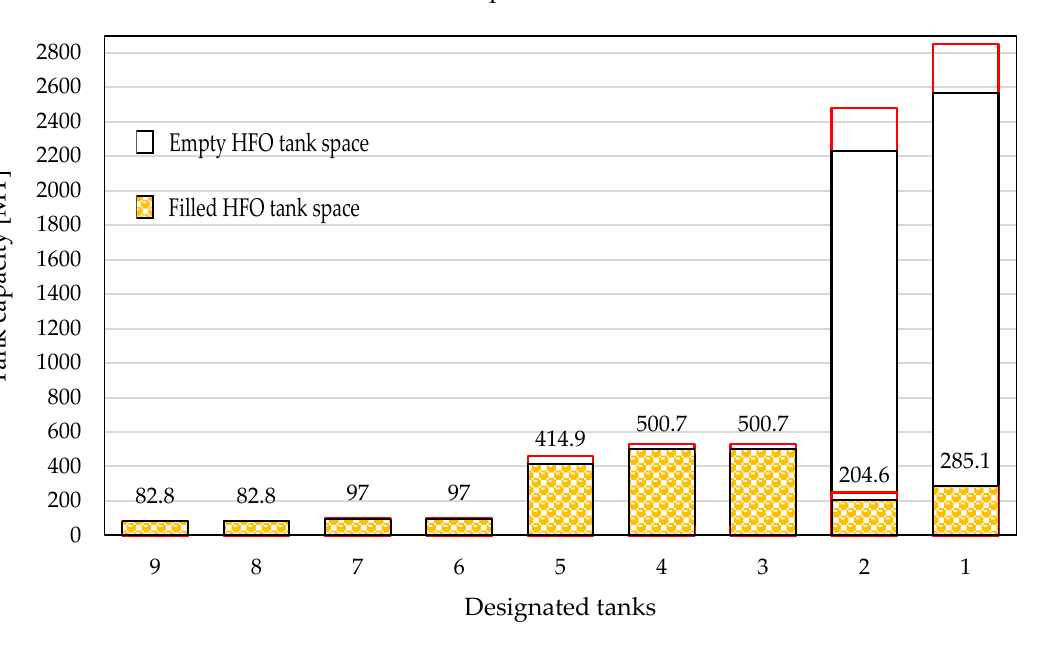
Figure 5. HFO bunker condition before bunker distribution for the second example.